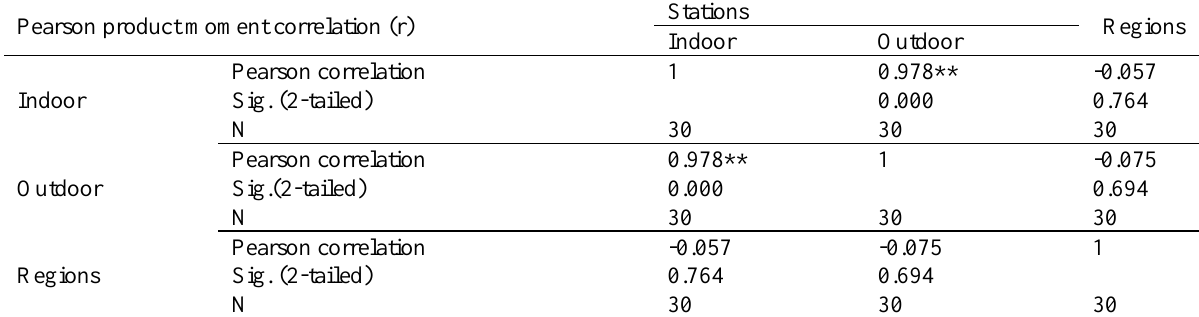
Table 4. Correlation of indoor and outdoor spaces in heavy metal concentrations Pearson product moment correlation